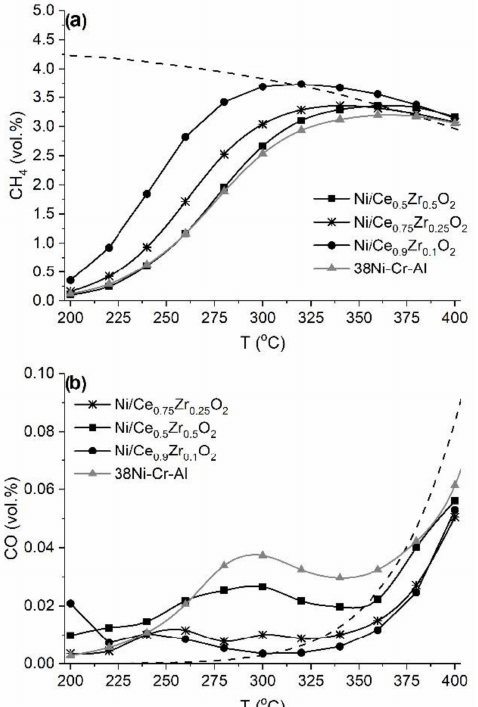
Figure 8. Temperature dependences of the outlet concentrations of CH 4 ( a ) and CO ( b ) during CO 2 methanation over the Ni/Ce 1 − x Zr x O 2 catalysts and 38Ni-Cr-Al catalyst. The dashed lines correspond to the calculated equilibrium